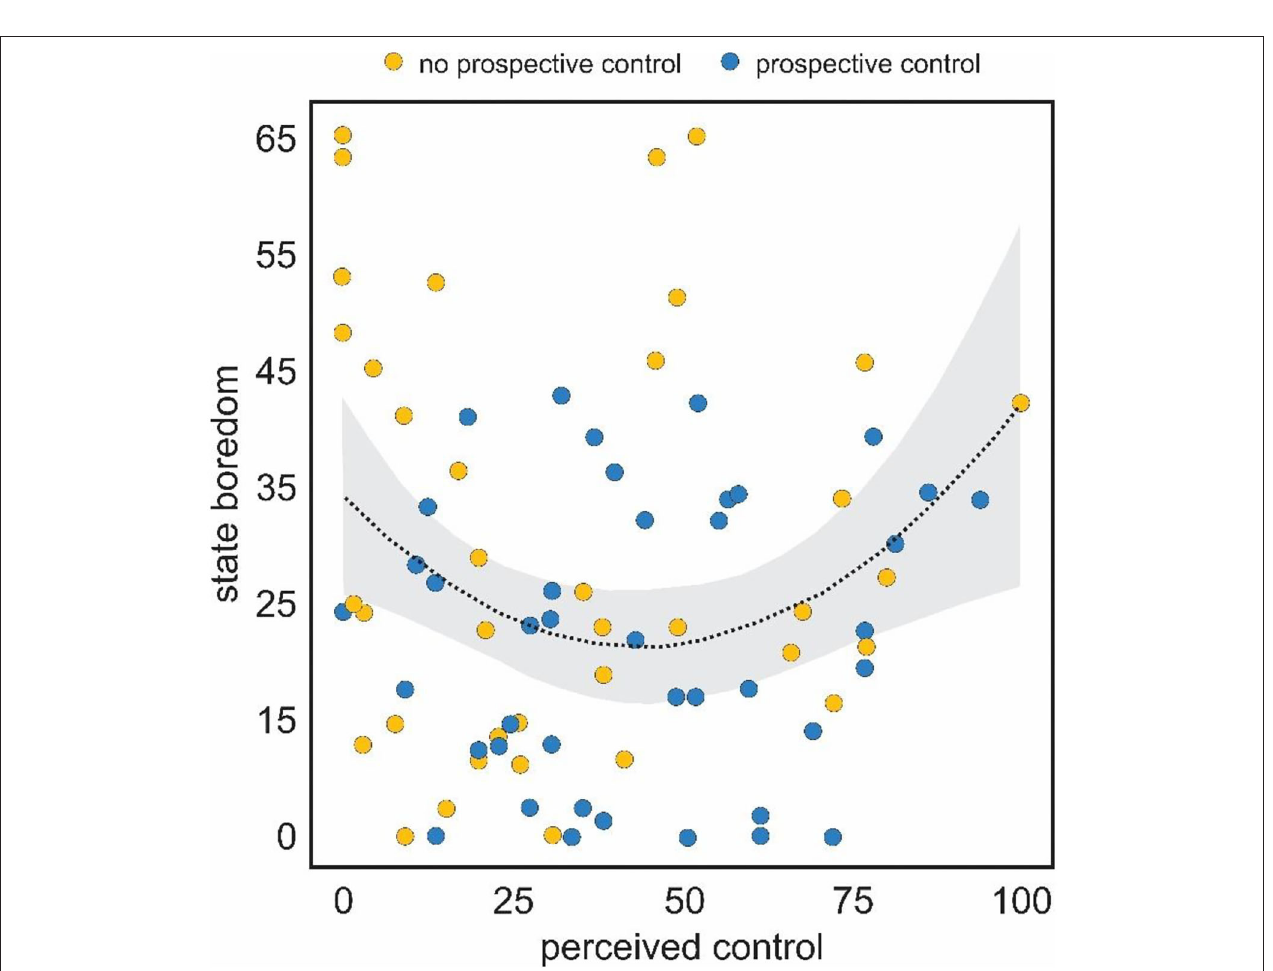
FIGURE 4 | Curvilinear relationship between self-reported ratings of state boredom (y-axis) and perceived control (x-axis). Boredom was highest at the low and high ends of perceived